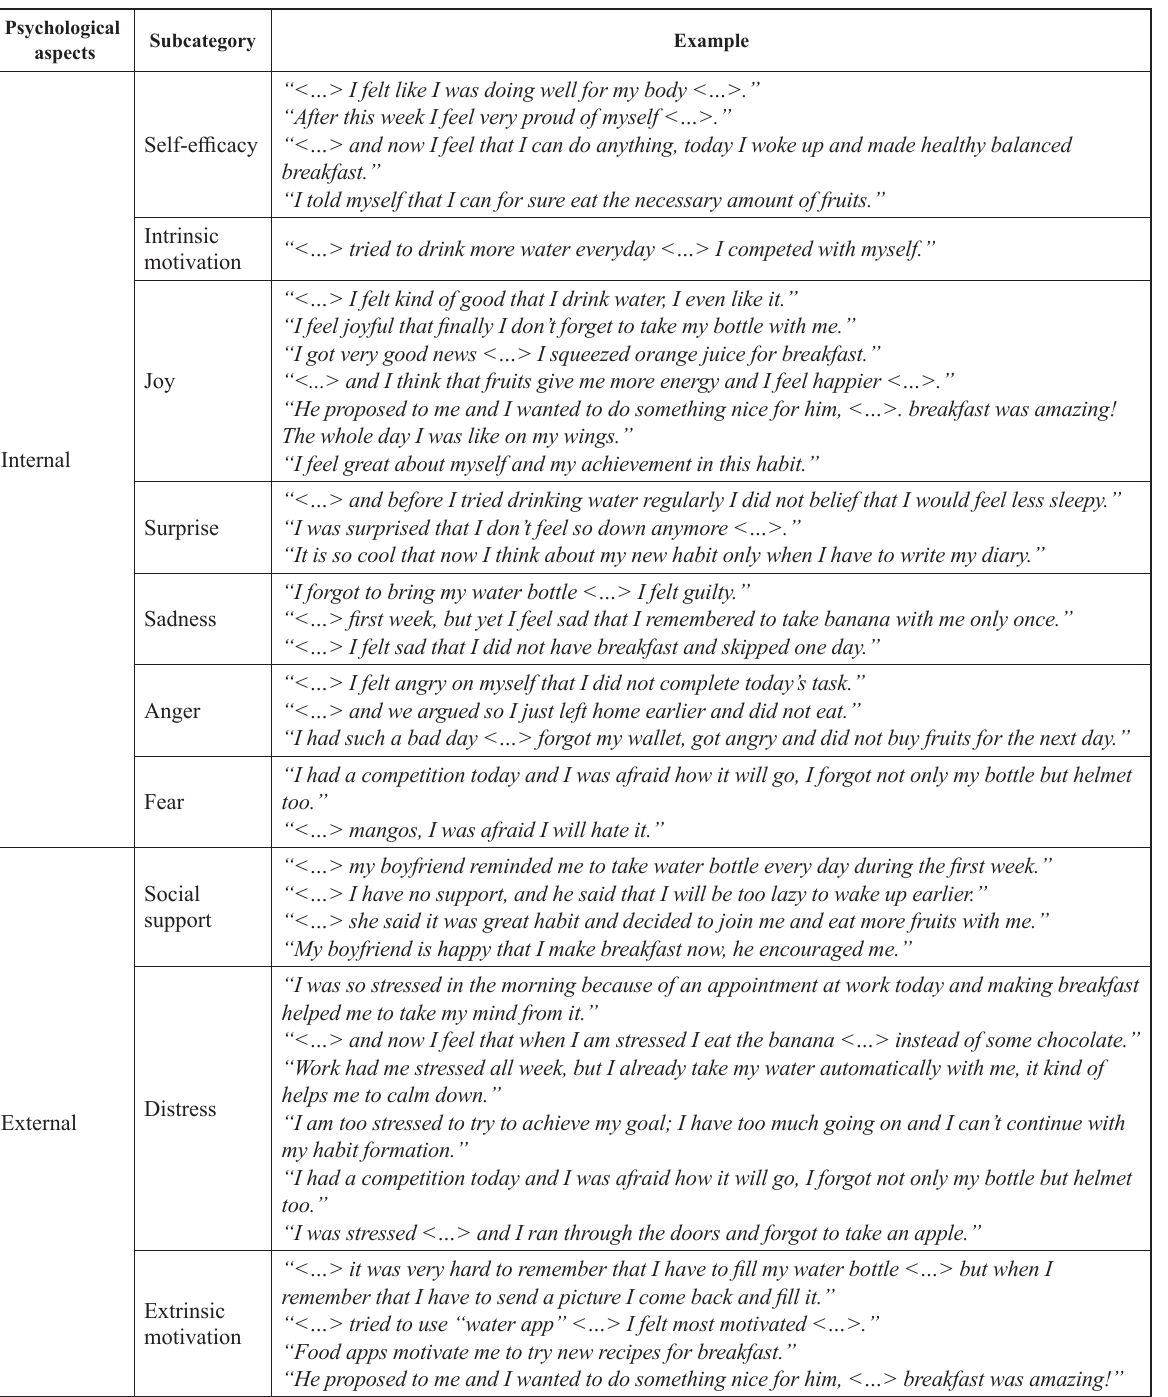
Table 4. Psychological aspects related to the development of nutritional